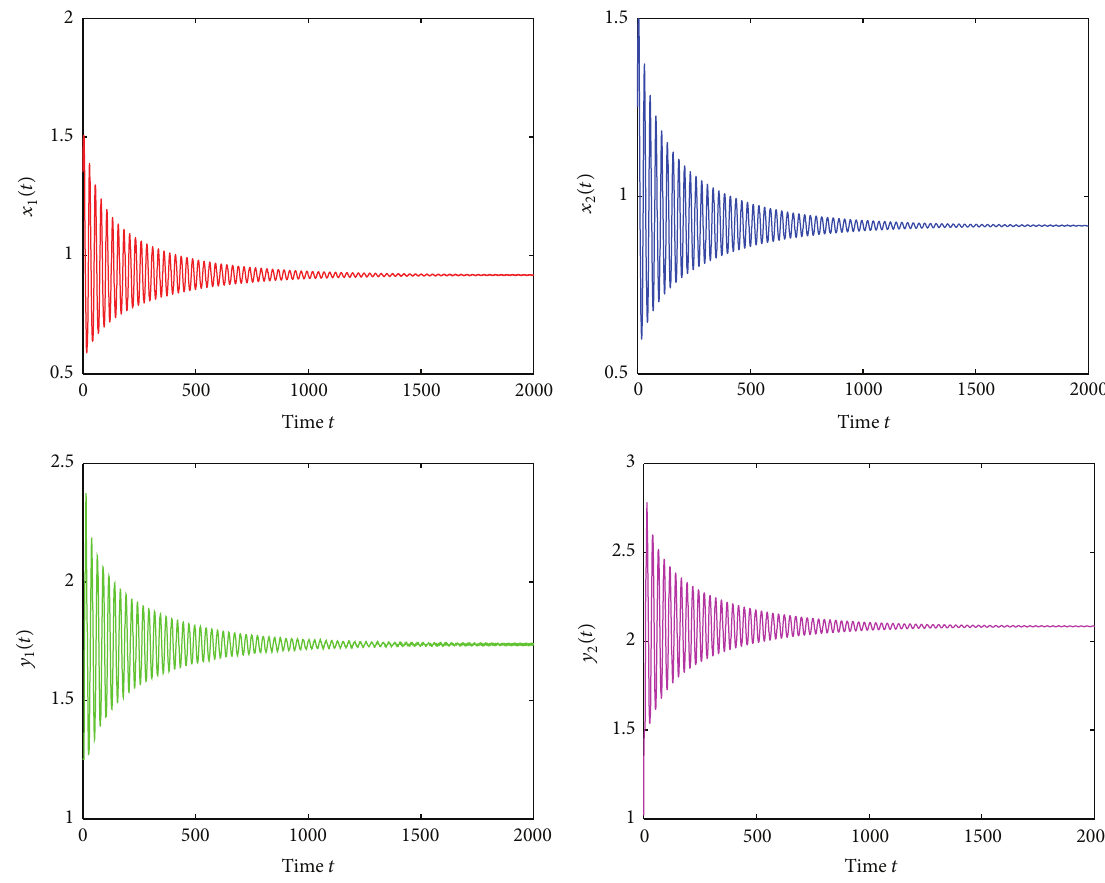
Figure 19: The track of the states 𝑥 1 , 𝑥 2 , 𝑦 1 , 𝑦 2 for 𝜏 2 = 5.5500 < 𝜏 ∗ 2 = 6.6494 and 𝜏 ∗ 1 = 2.5000 .